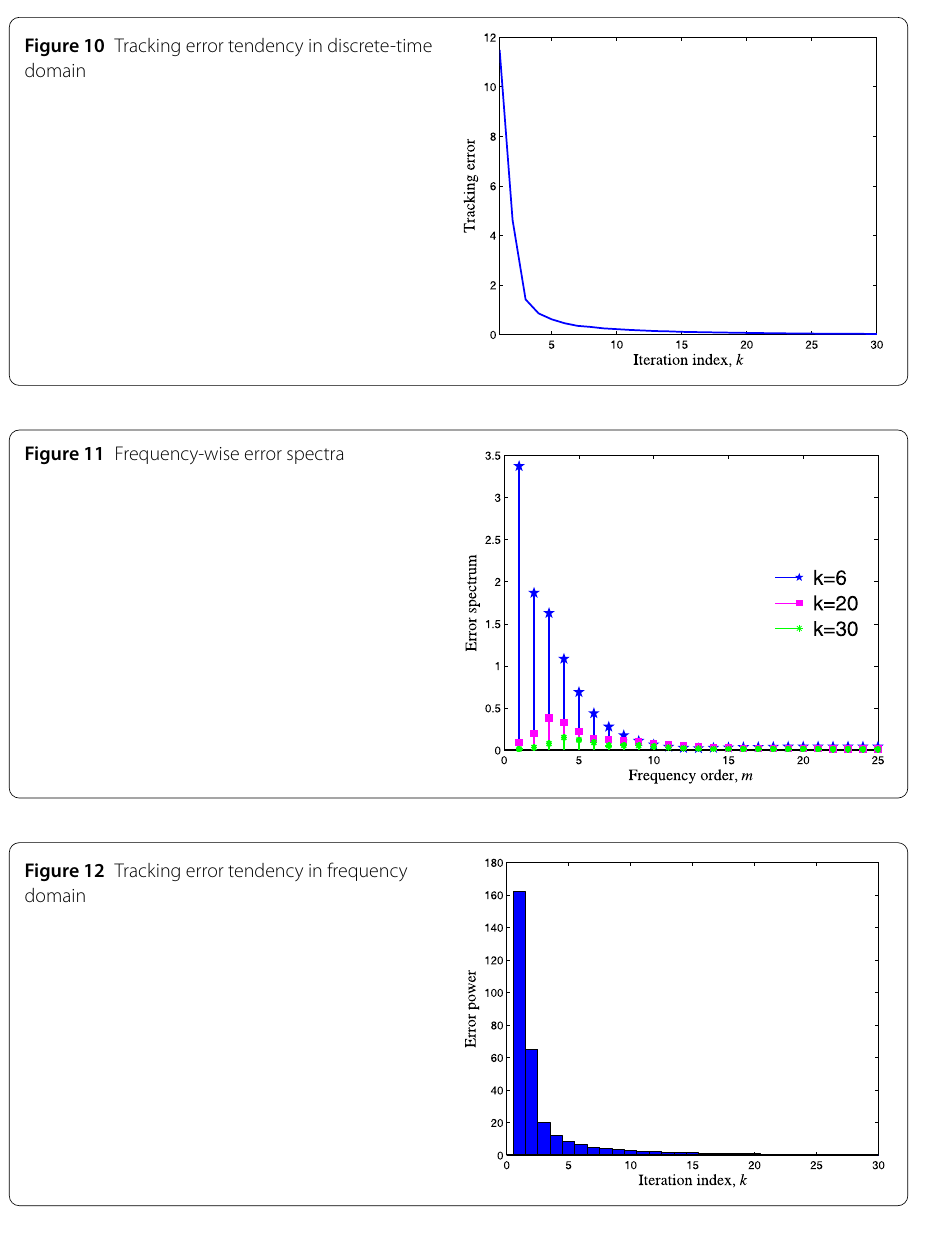
Figure 10 Tracking error tendency in discrete-time domain